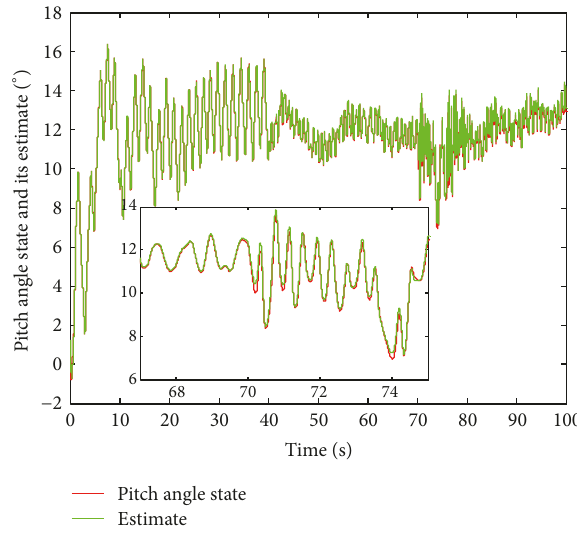
Figure 5: Pitch angle and its estimate with 𝑓 𝑠 = −